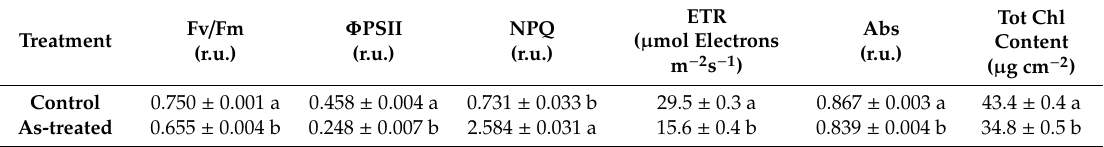
Table 2. Total chlorophyll content and chlorophyll fluorescence parameters measured in Pteris vittata L. plants treated (As-treated) or not (control) for 9 weeks with 28 mg L − 1 Na 2 HAsO 4 · 7H 2 O under hydroponic conditions in greenhouse at the end of the experiment. Maximum quantum yield of PSII photochemistry(F v / F m )measuredindarkadaptedleavesandquantume ffi ciencyofPSIIphotochemistry ( Φ PSII), non-photochemical quenching (NPQ), electron transport rate (ETR), and PAR-absorptivity (Abs) measured at steady state with actinic light illumination of 150 µ mol photons m − 2 s − 1 (Mean data ± SE; n = 5). Data followed by di ff erent letters in the same column are significantly di ff erent (Tukey’s test, p ≤